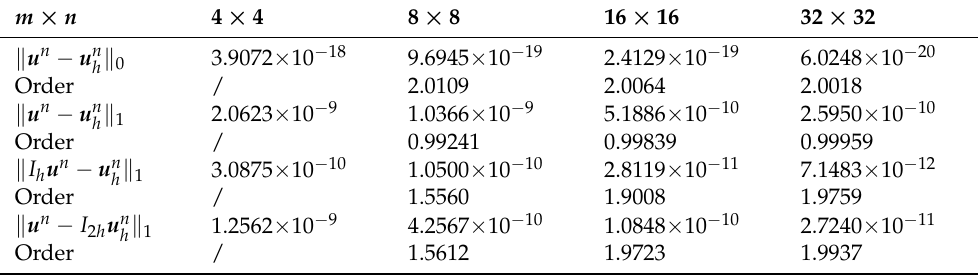
Table 7. The numerical errors and convergence orders at t = 10 of u .